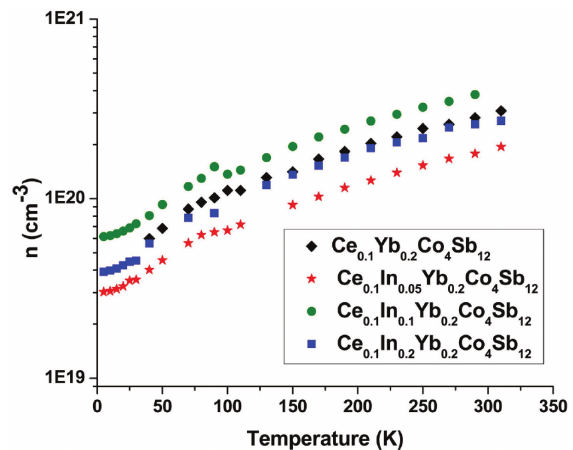
Figure 6. Temperature dependent carrier concentration of the Ce 0.1 In y Yb 0.2 Co 4 Sb 12 skutterudites confirming the improvement in